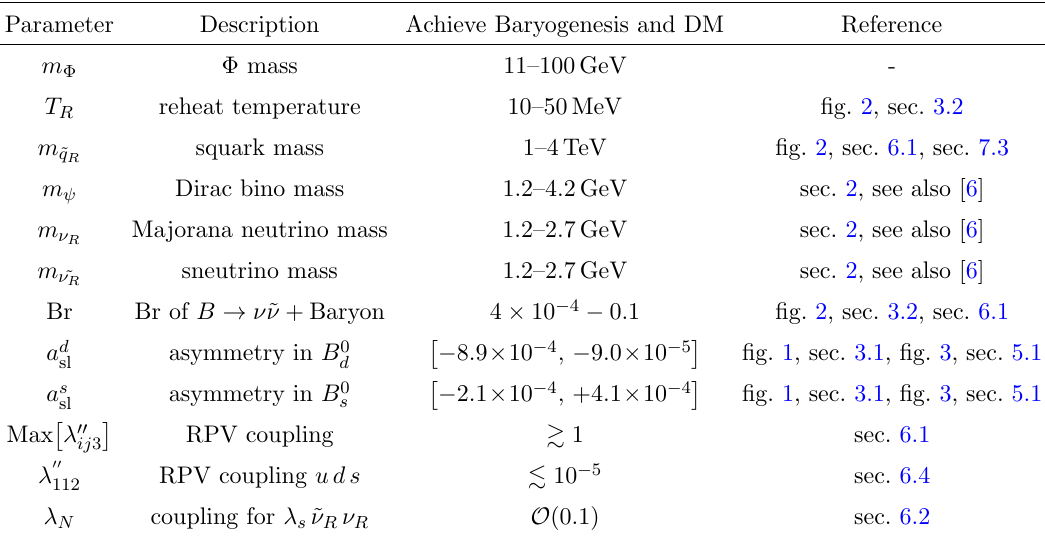
Table 5. Ranges of parameters relevant for generating the observed baryon asymmetry ( Y 8 : 7 10 (cid:0) 11 ) and DM abundance ((cid:10) DM h 2 = 0 : 12) of the Universe and which are consistent with all (cid:2) experimental constraints. For convenience, in the third column we provide a link to the relevant section in this paper where each result is